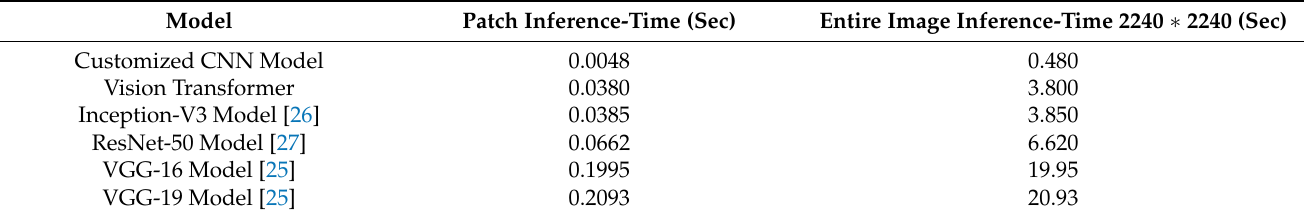
Table 5. Comparison of models’ computational